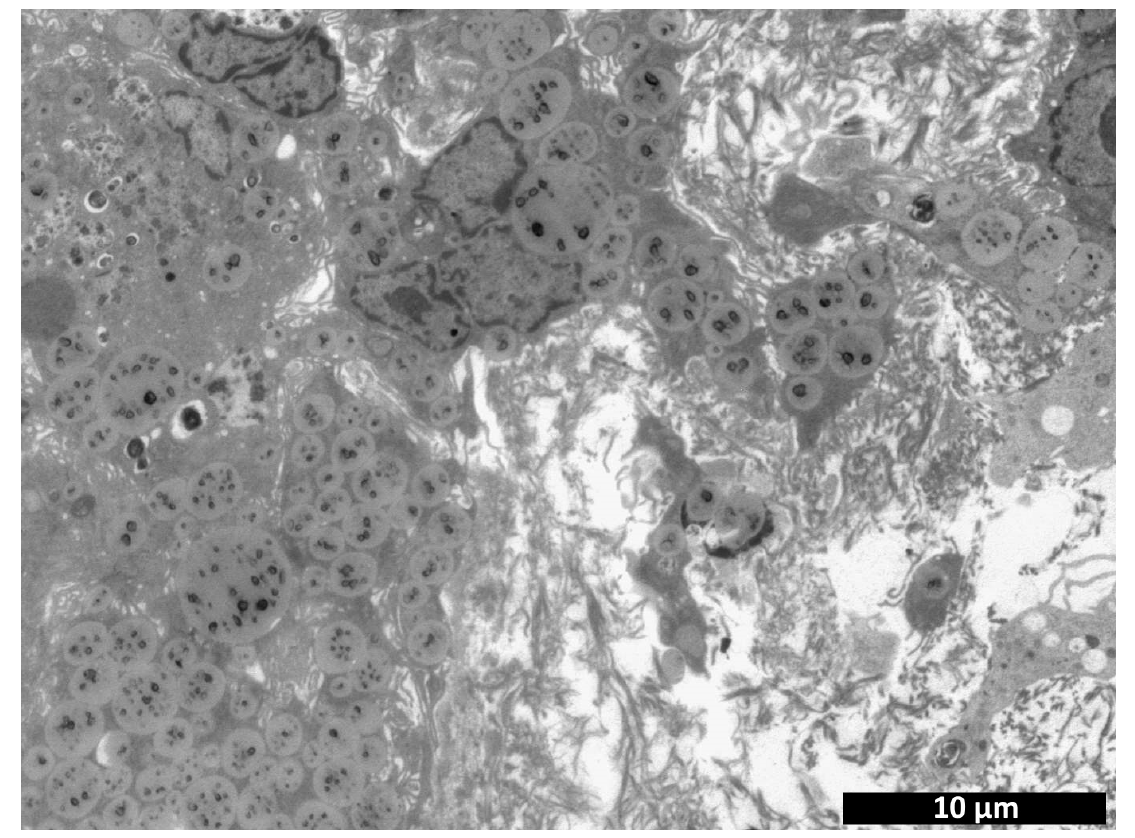
Figure 13. Vesiculation of scaffold (CCS), its removal by cells and replacement by collagen fibers 7 days after implantation.